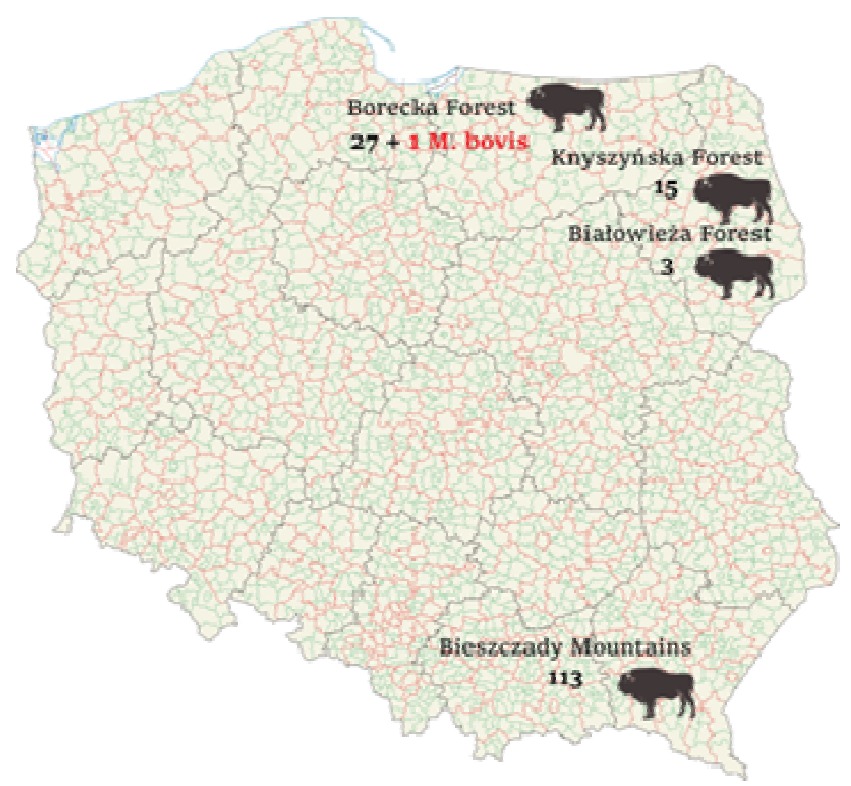
Figure 1. Location of the free-living herds from which the animals were tested. Retropharyngeal, tracheobronchial, mediastinal lymph nodes, a lung, and a liver seg- ment were collected from animals with preserved whole bodies (n = 149). In the remaining 10 cases, the person collecting the samples dissected retropharyngeal and inguinal lymph nodes (n =